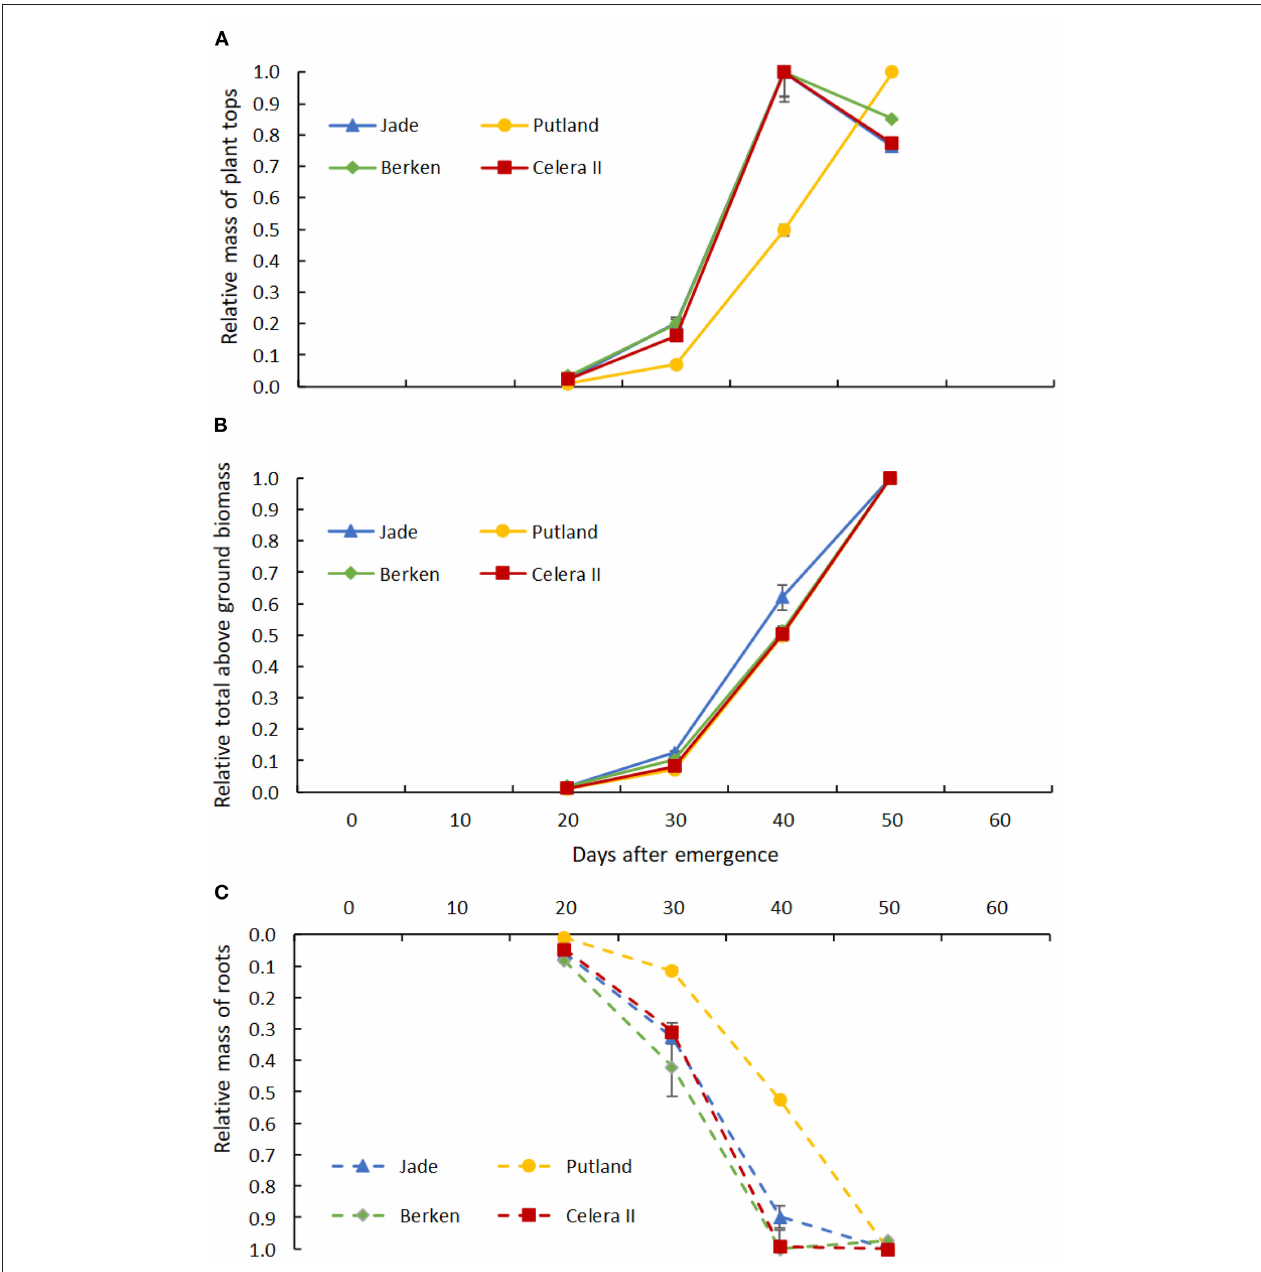
FIGURE 6 | Relative mass of (A) plant tops (leaf + stem) and relative mass of (B) aboveground biomass (leaf + stem + pods) to relative mass of root (C) from 20 days to 50 days of plant growth for four varieties; Jade, Putland, Berken and Celera II. Error bars indicate + / − standard error of